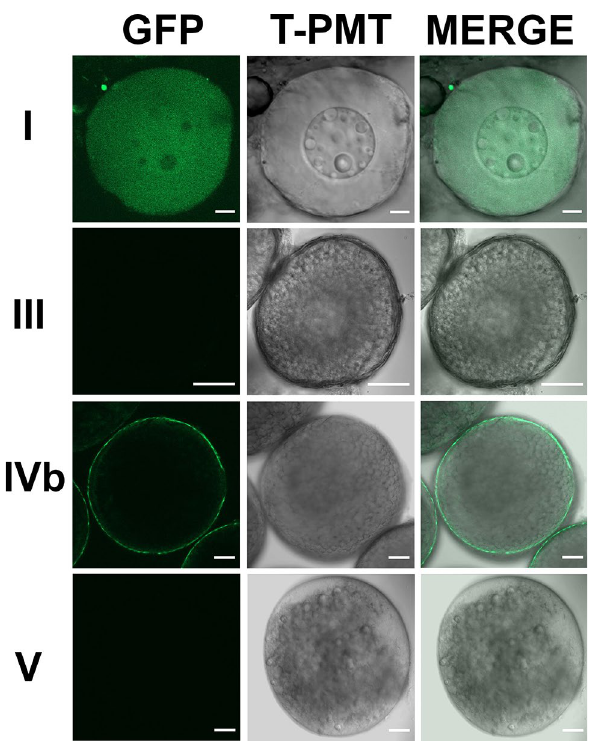
Figure 3. Strong expression of Adamts9 in preovulatory follicles, weak or no expression in immature ovarian follicles or ovulated oocytes in Adamts9 transgenic lines ( Tg(adamts9:GFP) ). The expression of Adamts9 was determined by EGFP expression driven by adamts9 promoters located in a 4.5 kb upstream sequence of adamts9 start codon. Representative confocal slice images of stage I (immature pre-vitellogenic), III (immature vitellogenic), IVb (mature & preovulatory) follicles and stage V ovulated oocytes were shown. Follicles or oocytes were confocal imaged under EGFP and transmit light (T-PMT) channels. Similar expression was confirmed in the follicles or oocytes of several F1 and F2 adult females from five independent transgenic lines. Scale bar: 10 μm (stage I); 100 μm (stages III, IVb,